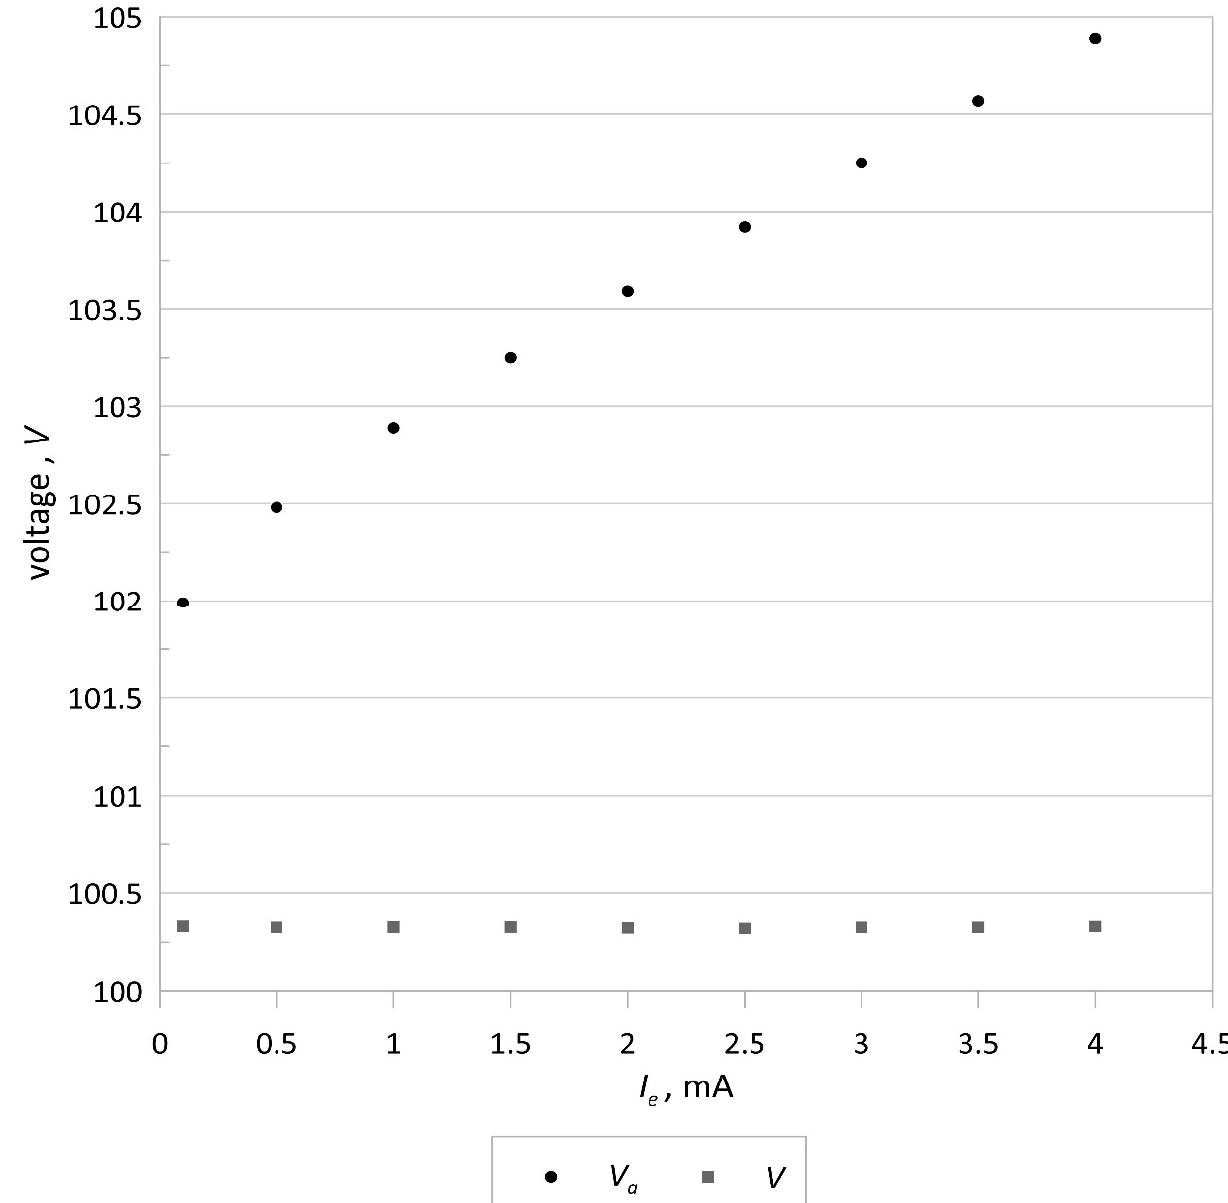
Figure 4. Results of the feedforward control of the electron accelerating voltage V .